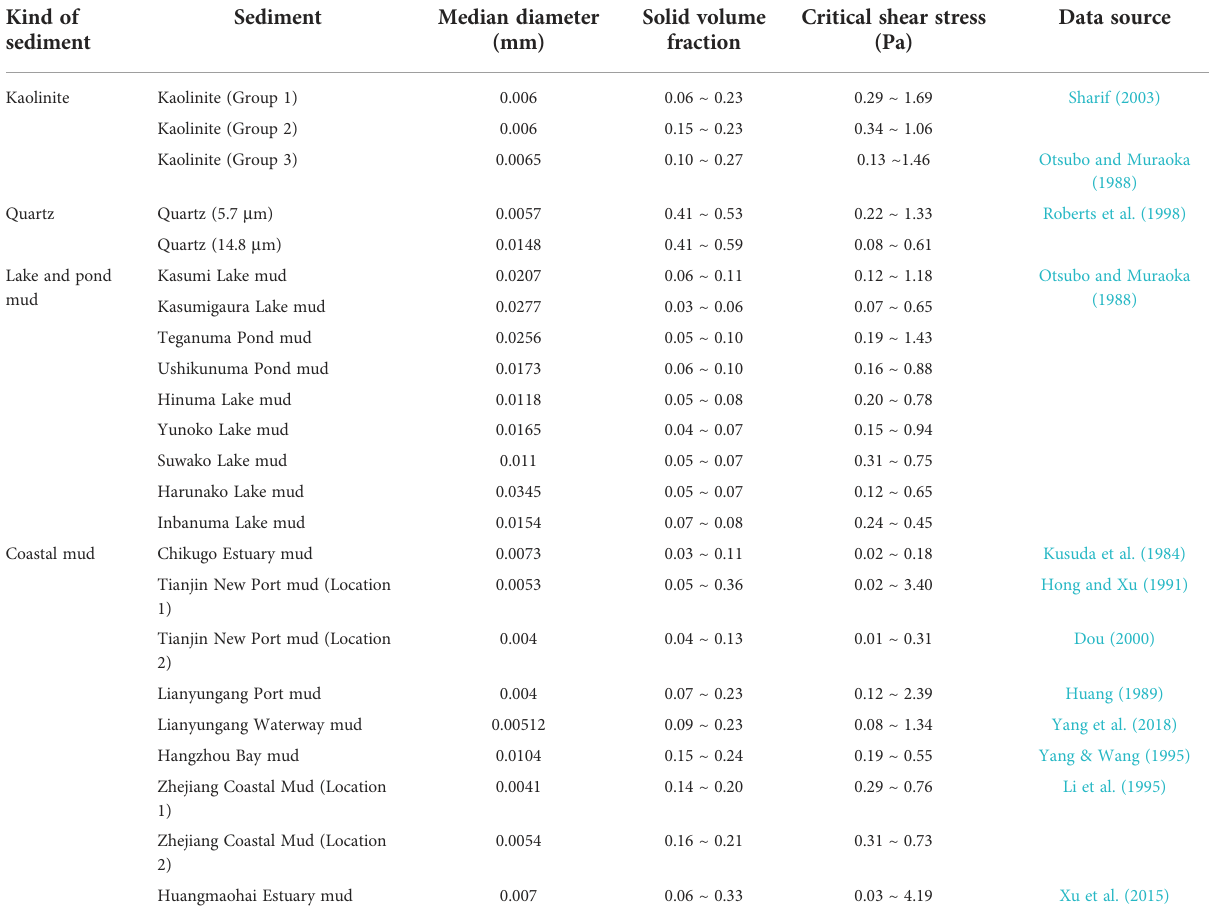
TABLE 1 Summary of collected experimental data of and data